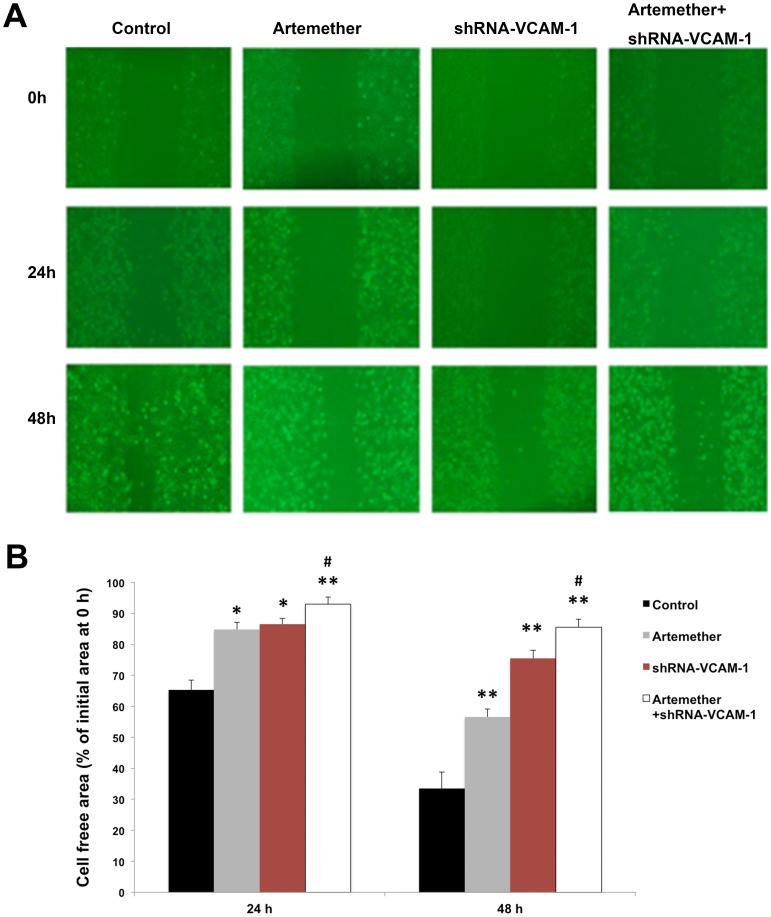
The effects of shRNA-VCAM-1 alone or combined with artemether upon the migration capacity of U87 cells.The effects of artemether on the migration of U87 cells were assessed by wound healing assay. (A) Parental U87 cells and shRNA-VCAM-1-U87 cells were treated with or without artemether (300 µmol/L, 48 h). (B) Statistical analysis of migrating cell numbers. The migration of shRNA-VCAM-1 U87 cells was inhibited significantly compared with control group and the artemether+shRNA-VCAM-1 group displayed the greatest inhibitory effects. (X200). *P<0.05, **P<0.01 (compared with the control group); #
P<0.05, (compared with artemether and shRNA-VCAM-1 groups). n = 4.